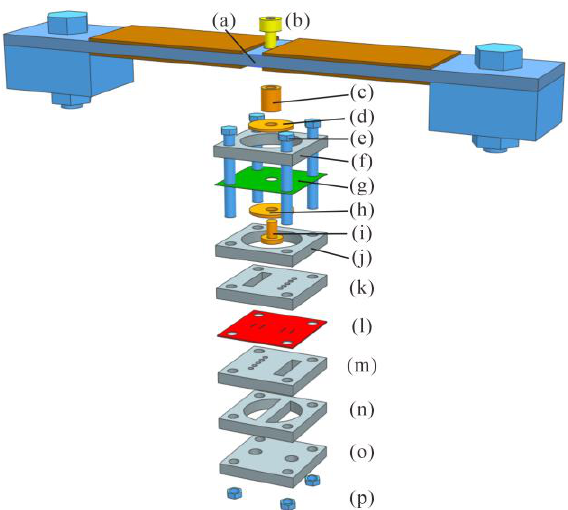
Figure 8. Exploded view of the designed piezoelectric pump: ( a ) piezoelectric resonator; ( b ) screw; ( c ) linker; ( d ) annular gasket; ( e ) bolts; ( f ) polymethylmethacrylate (PMMA) chamber fix plate; ( g ) Kapton diaphragm; ( h ) annular gasket; ( i ) screw; ( j ) PMMA pump chamber plate; ( k ) PMMA outlet/inlet valve seat plate; ( l ) PDMS film of check valves; ( m ) PMMA inlet/outlet valve seat plate; ( n ) PMMA flow channel plate; ( o ) PMMA inlet/out seat plate; ( p ) nuts.